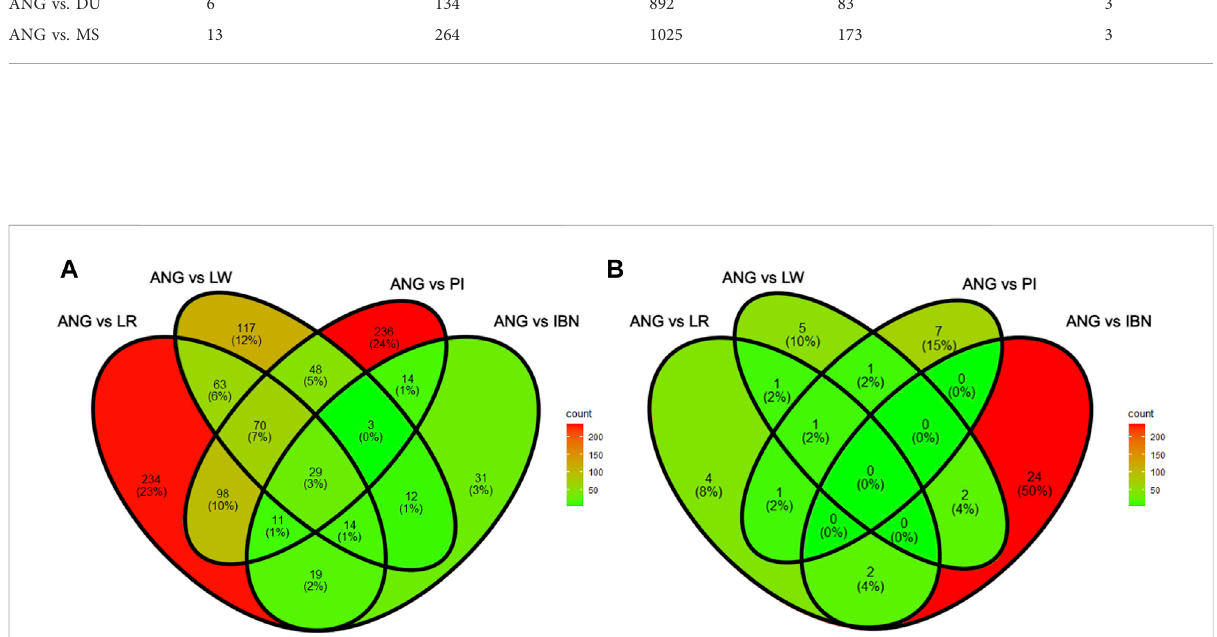
TABLE 2 Selected outlier regions exhibiting strong positive selection in cross-population Extent Haplotype Homozygosity (xpEHH) analysis. Breed pairs Number of outlier regions ANG vs. IBN 55 1,277 1125 28 ANG vs. LR 19 391 2,623 204 9 ANG vs. LW 16 329 2031 214 10 ANG vs. PI 23 457 2,529 246 10 ANG vs. DU 6 134 892 83 3 ANG vs. MS 13 264 1025 173 3